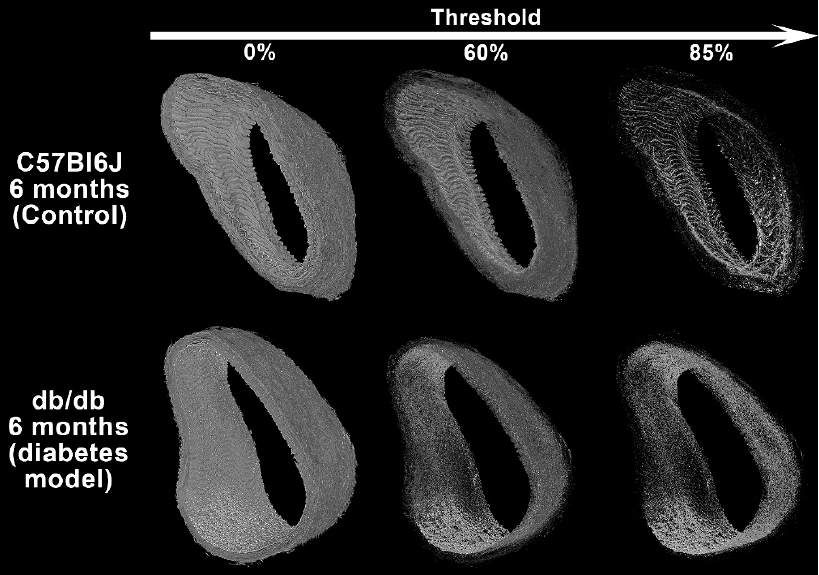
Figure 4. Box charts of ratio r ec obtained for control (C57Bl6J) and diabetic (db/db) 6-month mice. ( a ) All regions together ( p -value < 0.004), ( b ) only the thoracic region ( p -value < 0.065), and ( c ) only the abdominal region ( p -value < 0.02).